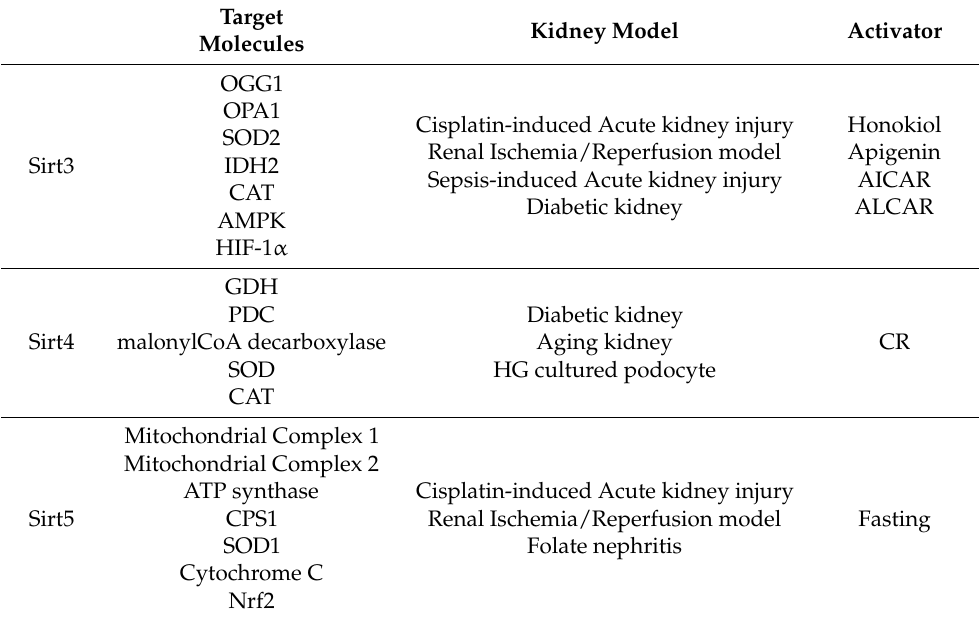
Table 3. Molecules targeted by sirt3, sirt4, and sirt5 for regulation of the oxidative stress and the activator of sirt3, sirt4, and